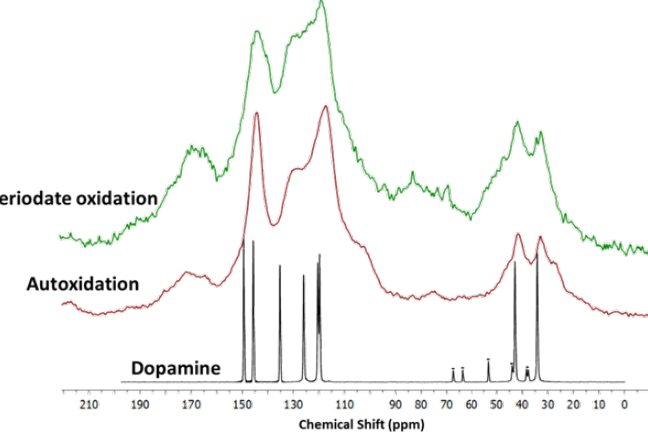
Figure 7. 13 C solid-state nuclear magnetic resonance (NMR) spectra of the polydopamine (PDA) samples produced by periodate oxidation (green trace) and autoxidation (red trace). The spectrum of dopamine (black trace) is reported as a reference (marked signals are due to spinning side bands). 1 5 N NMR spectra of autoxidation and periodate oxidation samples are reported in Supplementary Figure S3. In both spectra two main resonance groups, at 30 ppm (sp 3 hybridization) and 120–170 (sp 2 hybridization) ppm, are observed. The complex sp 2 band, centered at 130 ppm, is compatible with indole/pyrrole-like structures, however the poor resolution prevents a detailed assignment. The sp 3 /sp 2 intensity ratio is comparable in both samples.